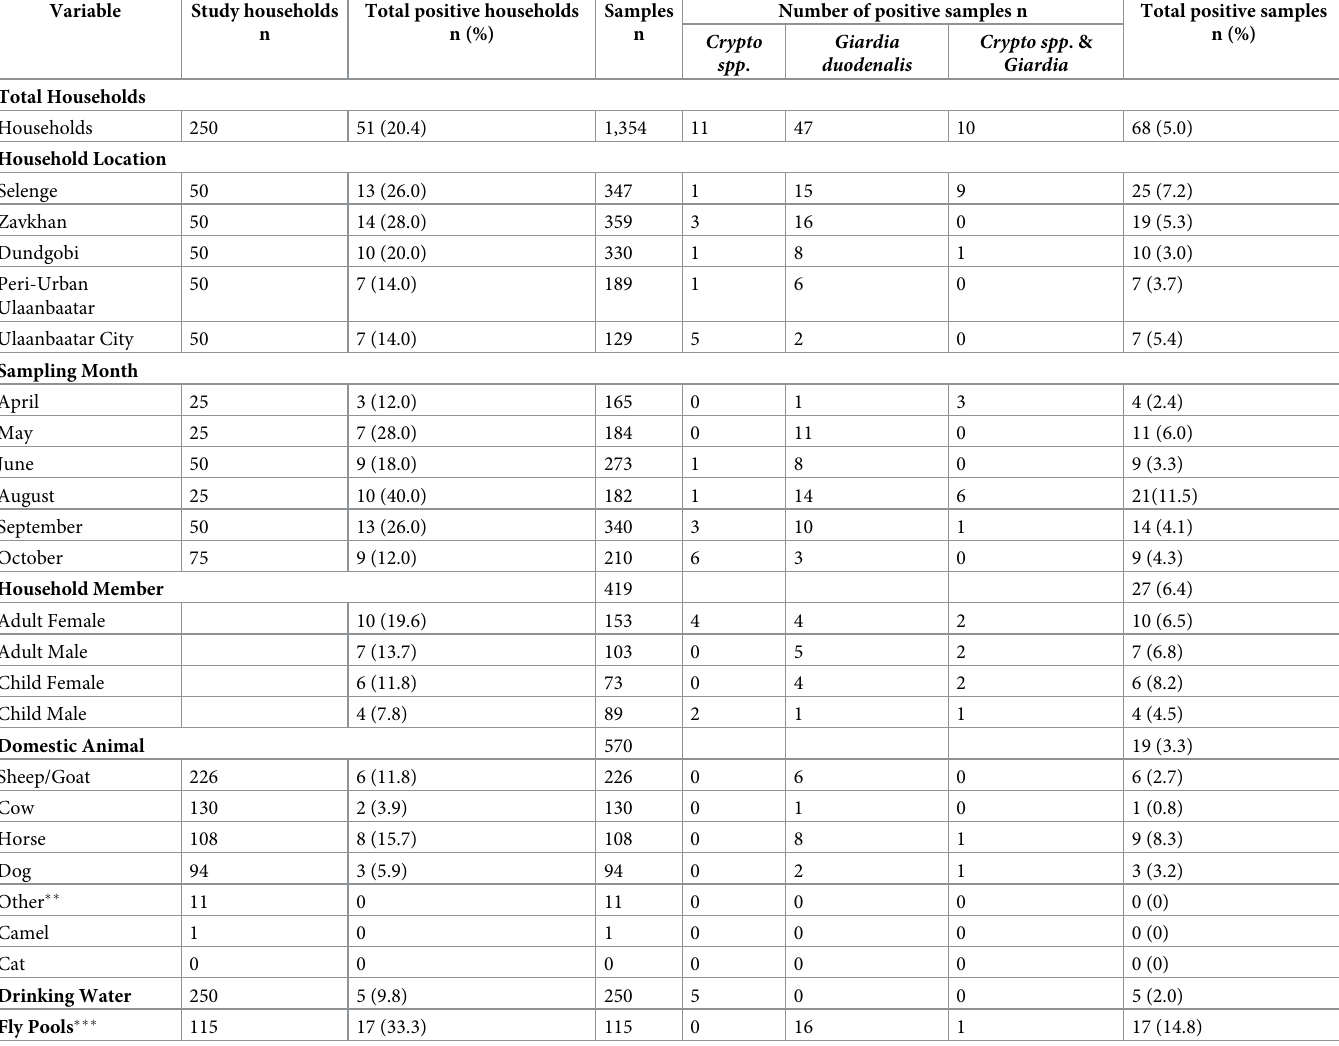
Table 1. Occurrence of Cryptosporidium spp . and Giardia duodenalis in human, animal, water, and fly samples (n = 1,354) collected at Mongolian study households (n =